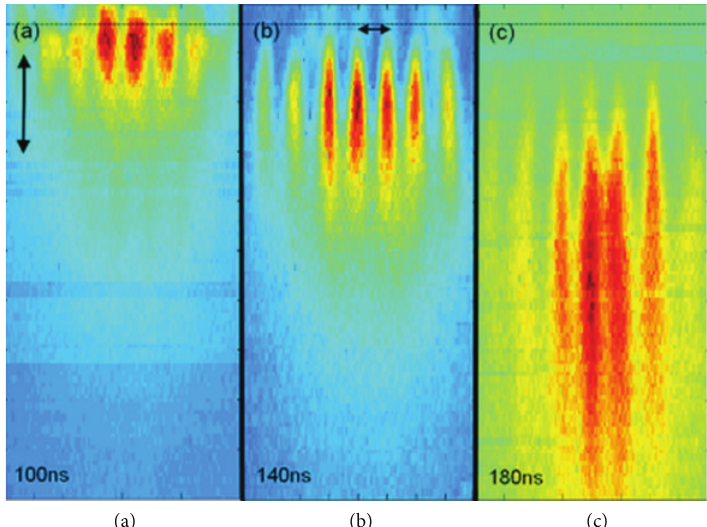
Figure 5: Monochromatic imaging of the plasma jets at different times using a 30ns gate. The dashed line marks the target’s surface, and the double arrows are 200mm scale